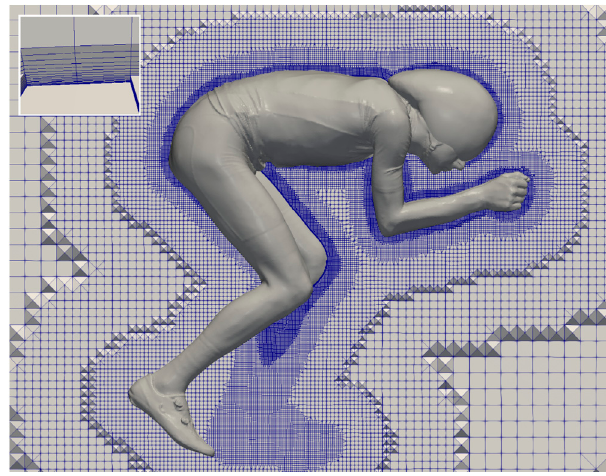
Figure 2. Illustration of grid refinement around the cyclist. The inset in the upper left shows a closeup of the prism layers near the cyclist